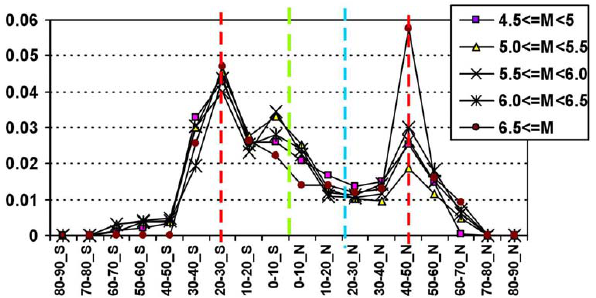
Figure 1. Binormed latitudinal distributions of earthquakes in the Pacific region for five Fig. 1. Binormed latitudinal distributions of earthquakes in the Pa- magnitude ranges; The horizontal axis is the latitudinal belts; vertical axis is binormed cific region for five magnitude ranges; the horizontal axis is the lati- number of earthquakes. Two red dotted lines correspond to peaks of binormed tudinal belts; vertical axis is binormed number of earthquakes. Two distribution; blue dotted lines correspond to local minimum and green dotted line is red dotted lines correspond to peaks of binormed distribution; blue situated on equator. dotted lines correspond to local minimum and green dotted line is situated on